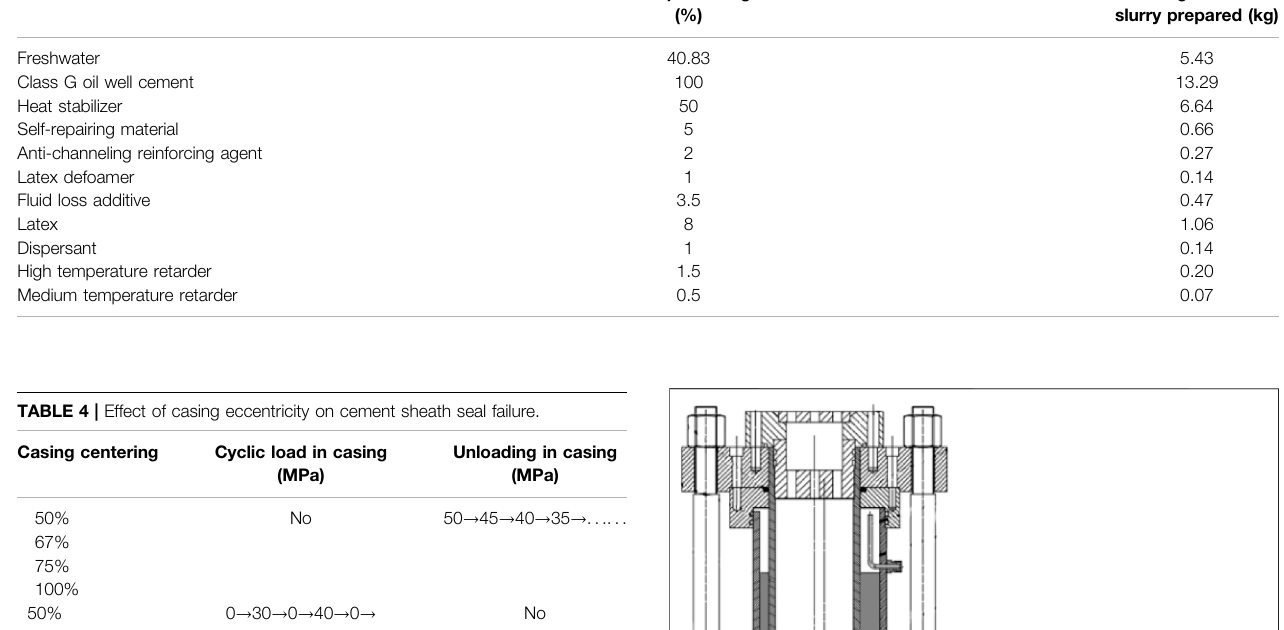
TABLE 3 | Formula of the cement slurry system for the experiment. Additional material